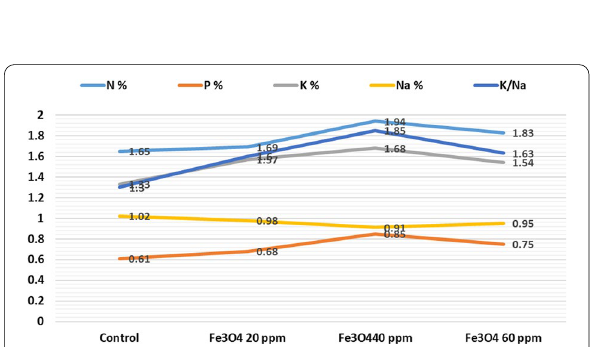
Fig. 5 Effect of foliar application with Fe 3 O 4 NPs on nutrients content of Moringa oleifera L. (LSD 5%: N % % NS, K/Na = =